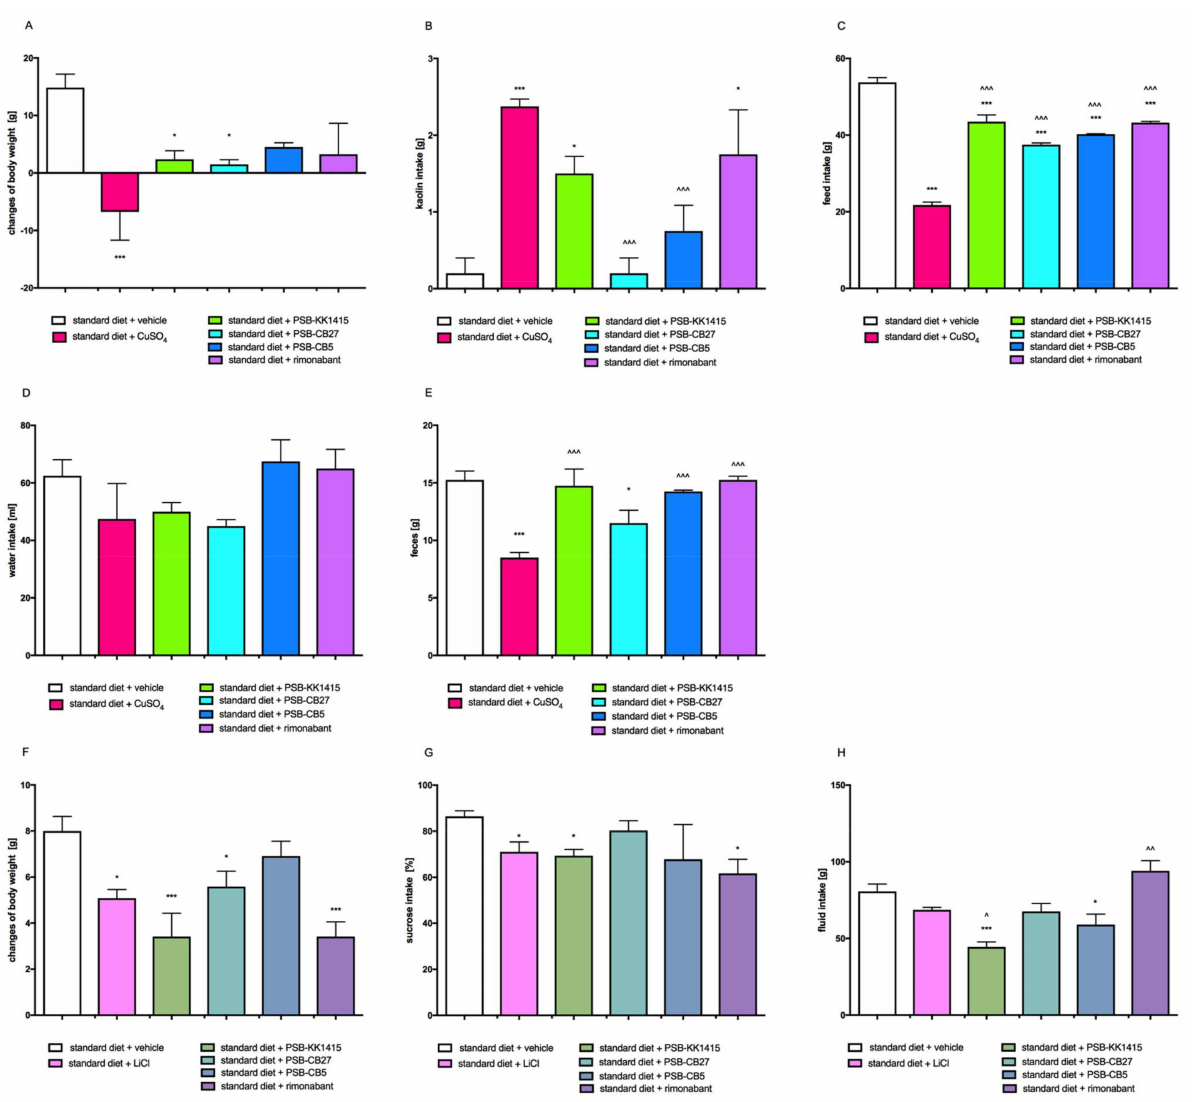
Figure 6. Effect of single administration of the GPR18 ligands or rimonabant, on body weight ( A ), kaolin intake ( B ), food intake ( C ), water intake ( D ), the amount of feces ( E ) of female Wistar rats in the Pica behavior model. The effect of multiple (seven days) administration of the GPR18 ligands or rimonabant, on body weight ( F ), sucrose intake ( G ), and fluid intake ( H ) of female Wistar rats in conditioned tested aversion model. Results are the means ± SEM, data for two animals are reared together, n = 6. Multiple comparisons against the vehicle-treated control group (*) or against the vehicle-treated obese control group (ˆ) were performed by one-way ANOVA Tukey post hoc. Significant differences are denoted by *,ˆ p < 0.05; ˆ p < 0.01; ***,ˆˆˆ p <